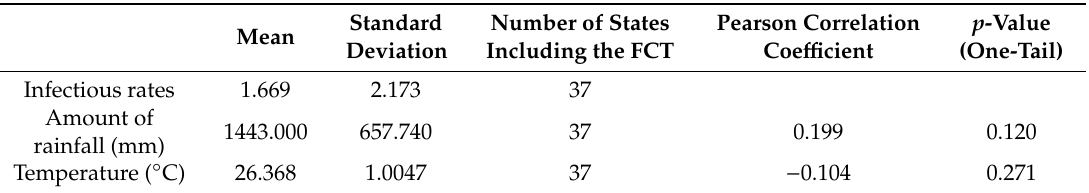
Table 3. Pearson correlations between COVID-19 infectious rates and weather conditions across 36 states and the FCT in